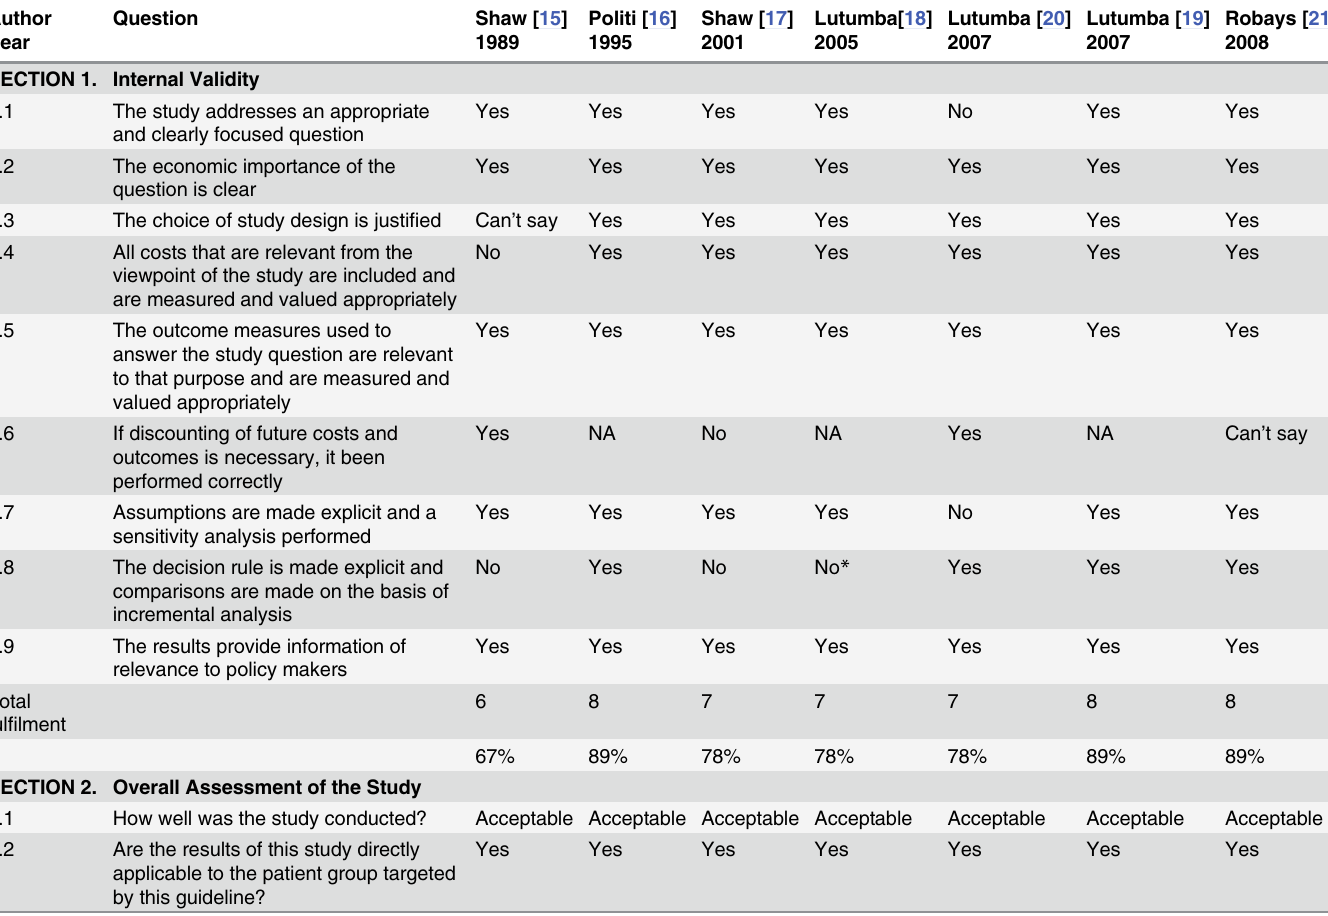
Table 2. Critical appraisal (Scottish Intercollegiate Guidelines Network (SIGN) Methodology Checklist 6: Economic